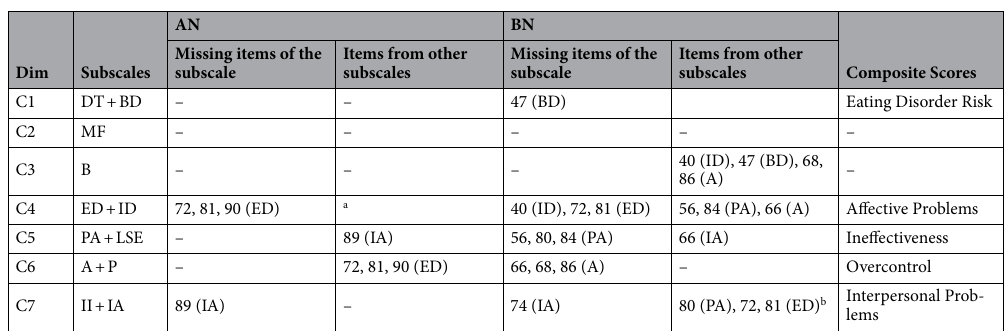
Table 4. Community structure of the median AN and BN networks in comparison to the theoretical dimensional structure of the EDI-3 questionnaire. a Plus item 71. b Plus item 71.